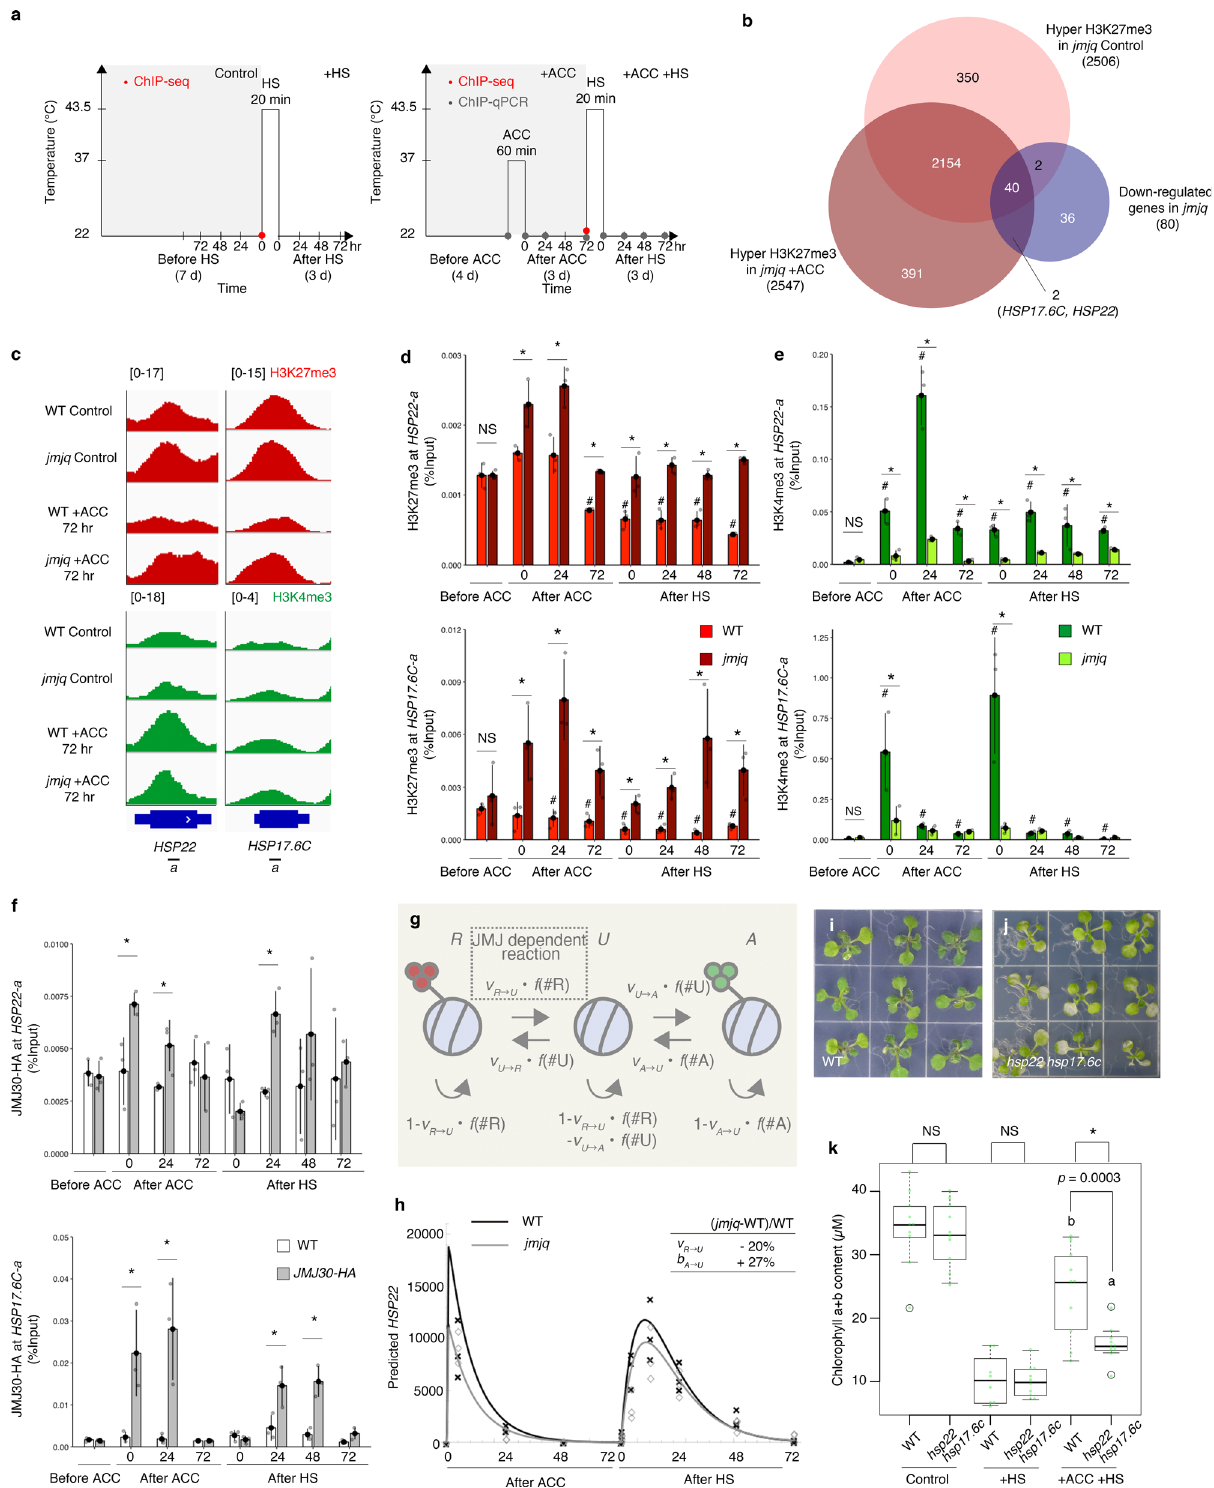
the model, HSP22 expression is immediately induced upon ACC and gradually induced after HS (Fig. 3h). Furthermore, the model predicted that HSP22 expression after HS would be lower in acclimatized jmjq mutants than in acclimatized wild type plants (Fig. 3h). Consistent with the biochemical function of JMJs, a comparison of the best- fi t parameters of the wild type and